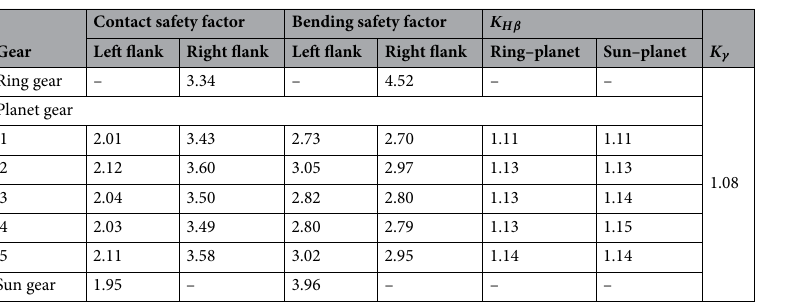
Table 4. Analytical results of the flexible pin model with microgeometry